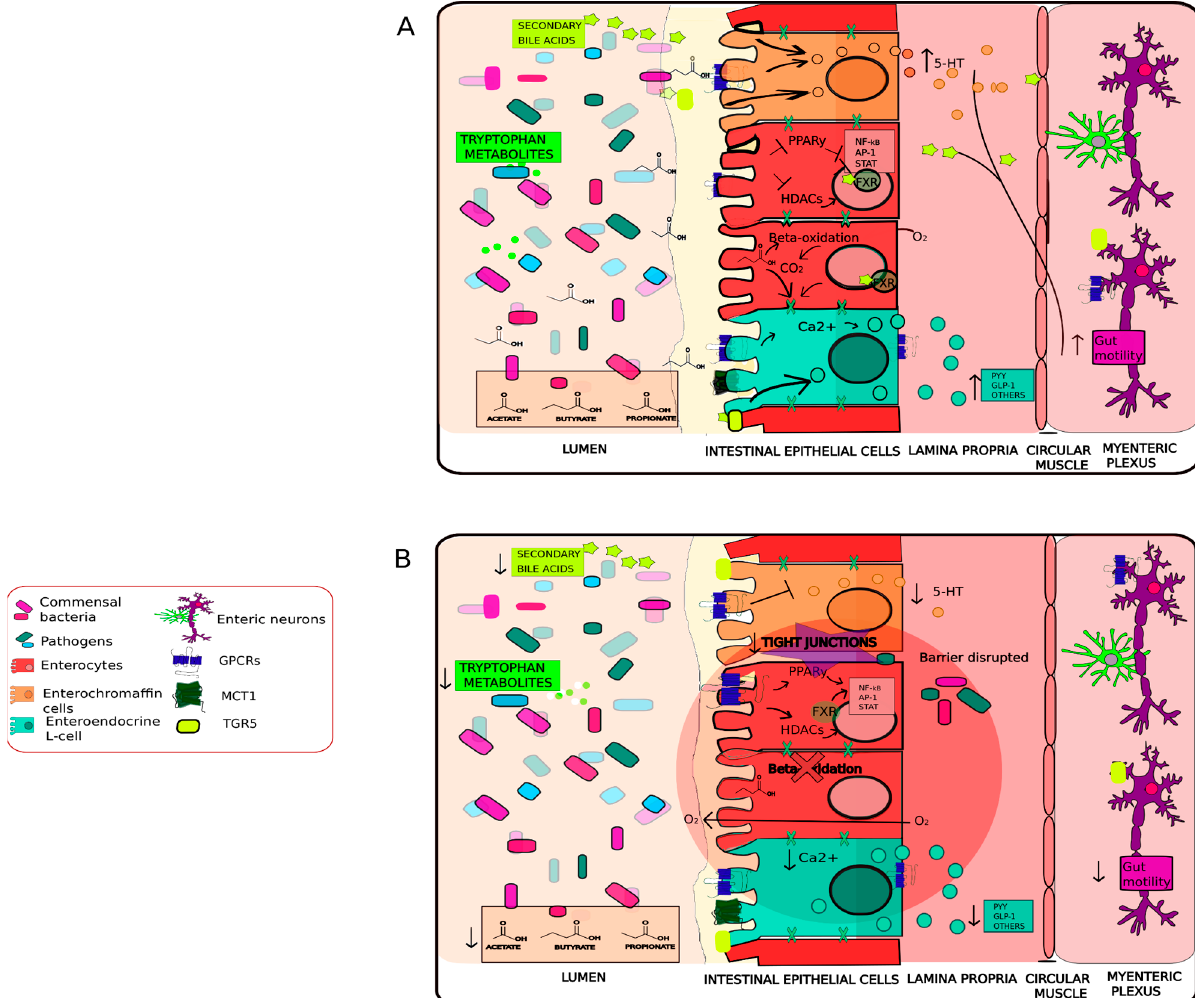
Figure 1. Bacterial metabolites signaling in the intestine. ( A ) Secondary bile acids, SCFAs and tryptophan metabolites are microbially derived metabolites. Secondary bile acids activate FXR and TGR5, which stimulate different types of cells. Enterochromaffin cells are stimulated promoting 5-HT release and motility in the colon. Enteroendocrine L-cells promote glucose tolerance through release of the incretin GLP-1. Enteric neurons with TGR5 stimulate or inhibit motility [128–130]. Bacterial fermentation of dietary fibers leads to the reduction in luminal pH and production of SCFAs [131].